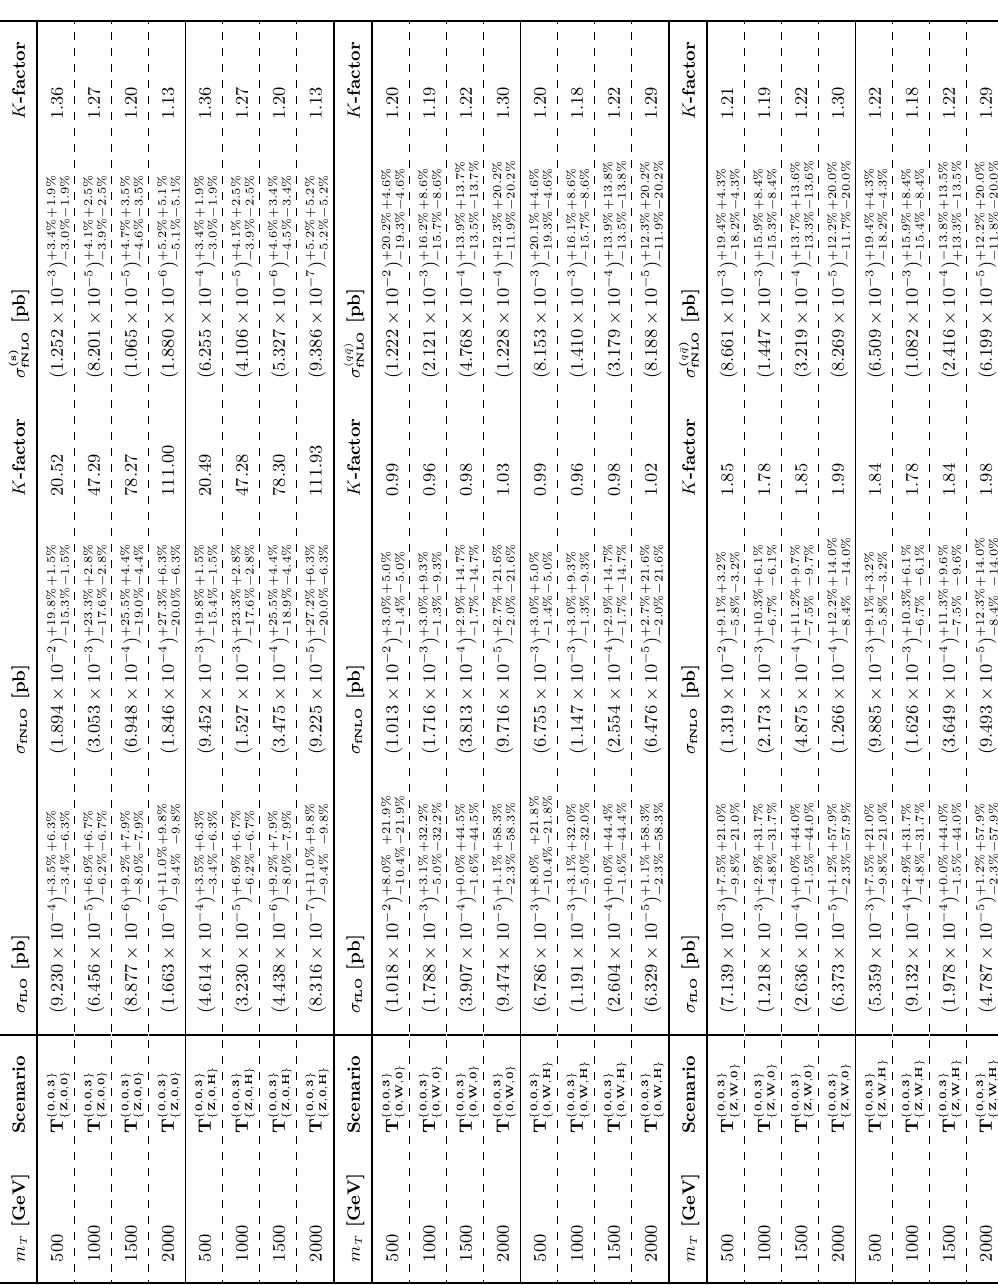
Table 1 . fLO and fNLO QCD inclusive cross sections for T (cid:22) t + (cid:22) Tt production at results are shown together with their associated scale (left) and PDF (right) uncertainties. The values of the external parameters are (cid:12)xed to: m H = 125 GeV, m Z = 91 : 1876 GeV, m t = 173 : 1 GeV, (cid:11) s ( m Z ) = 0 : 118 and G F = 1 : 16637 (cid:2) 10 (cid:0) 5 GeV (cid:0) 2 , where (cid:11) s ( m Z ) is the strong coupling constant at the Z mass.